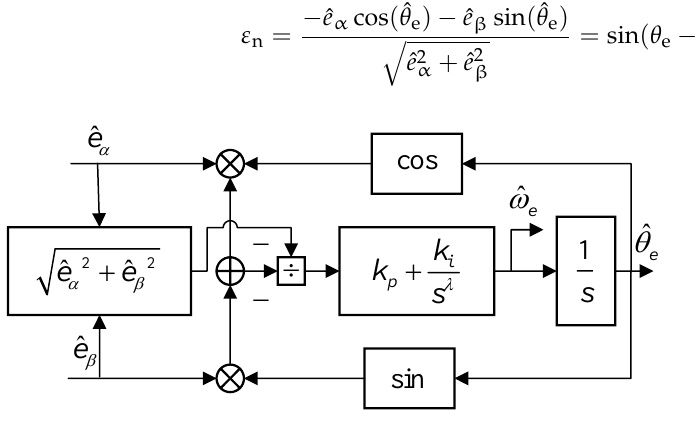
Figure 8. FN-PLL block diagram.